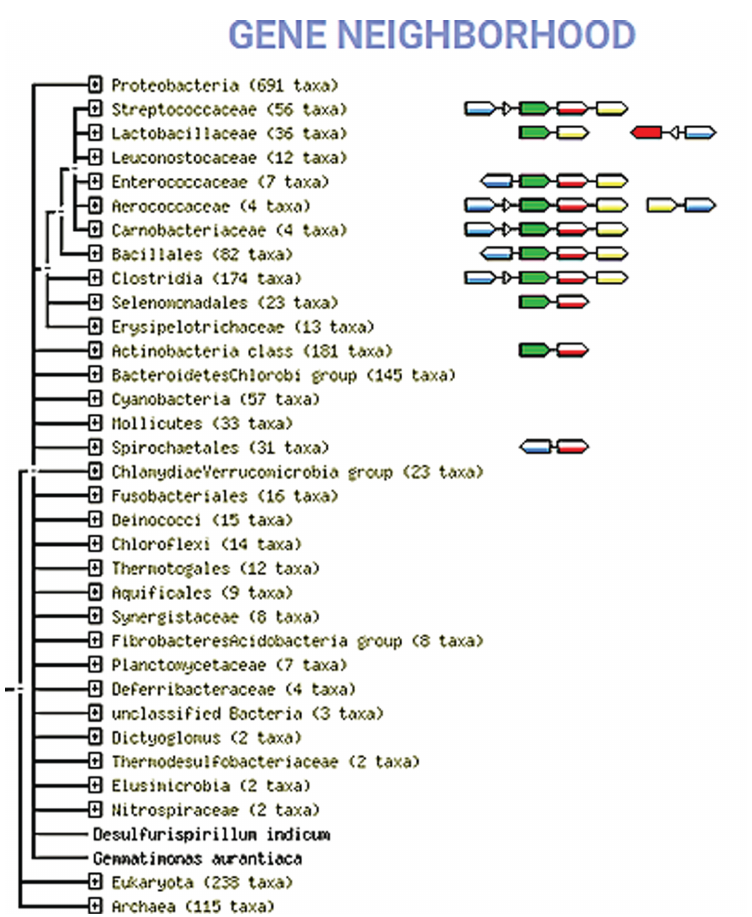
Figure 4: Co-occurrence and genomic proximity of genes encoding for homologs of cAD1 precursor (ref: Q82Z23, EF3256) and FAD: protein FMN transferase ApbE (ref: Q82Z24, EF1225). String database, gene neighbourhood view. cAD1 orthologs are depicted as green arrows, 1,4-dihydroxy- 2-naphtoate octoprenyltransferase (EF3254) – yellow arrows, and pyridine nucleotide-disulphide family oxidoreductase (EF3257)-blue arrows. The taxonomic tree used to display gene co-occurrence profiles was automatically generated by STRING and is based on canonical classification of all organism recorded in STRING database. The number of included taxa of low rank is shown in the brackets near each listed group name. STRING evaluates the phylogenetic distribution of orthologs of all proteins in a given organism. If two proteins show a high similarity in this distribution, i.e. if their orthologs tend to be observed as ‘ present ’ or ‘ absent ’ in the same subsets of organisms, then an association score is assigned